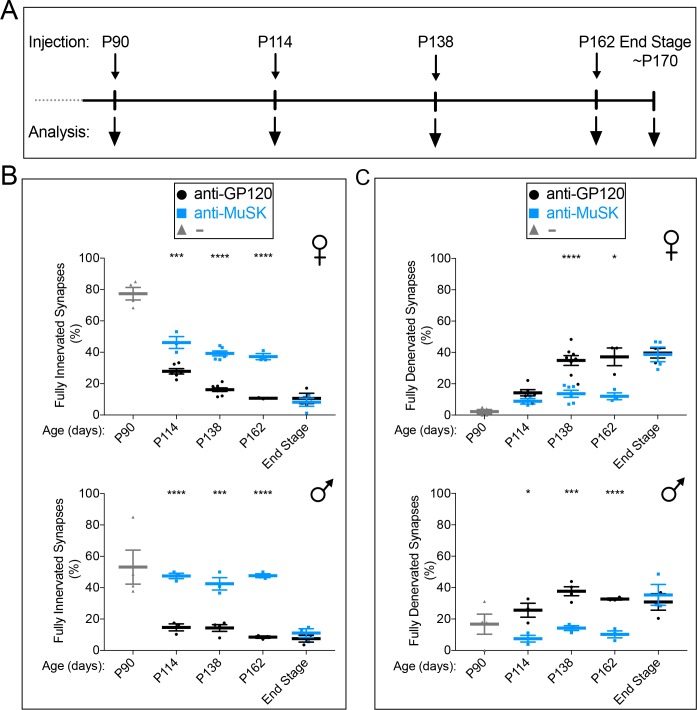
Chronic dosing with the MuSK agonist antibody prevents further denervation in SOD1-G93A mice.(A) The reverse chimera MuSK agonist antibody #13 was injected at P90 () (B) The extent of full innervation decreases progressively from P90 to P162 in female and male SOD1-G93A injected with a control antibody to GP120 (). The reverse chimera MuSK agonist antibody #13 () halts this progressive loss, as the number of fully innervated synapses is unchanged between P114 and P162. (C) Full denervation increases progressively from P90 to P162 in female and male SOD1-G93A injected with a control antibody to GP120 (). The reverse chimera MuSK agonist antibody #13 prevents this progressive increase in denervation, as the number of fully denervated synapses is unchanged between P114 and P162 (). At disease end-stage, the number of fully innervated and denervated synapses was identical in SOD1-G93A mice injected with the MuSK agonist or control antibody. The scatter plot shows the values for individual mice (n = 3 to 8), as well as the mean values and SEM; *p<0.05, ***p<0.001, ****p<0.0001.